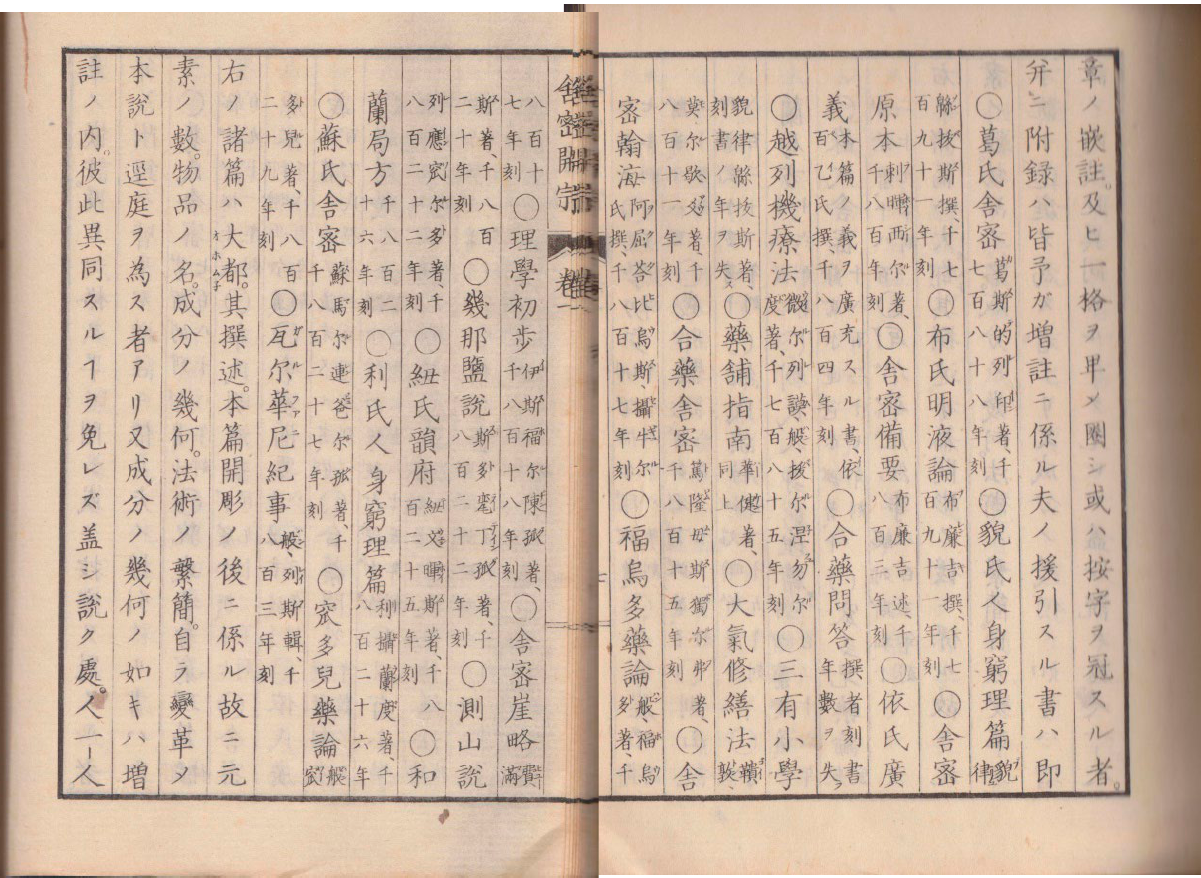
Figure 4. Names of Western authors and books in Udagawa Youan’s Seimi Kaiso book 1 vol. 1 p. 7. 11 Photo: Y.